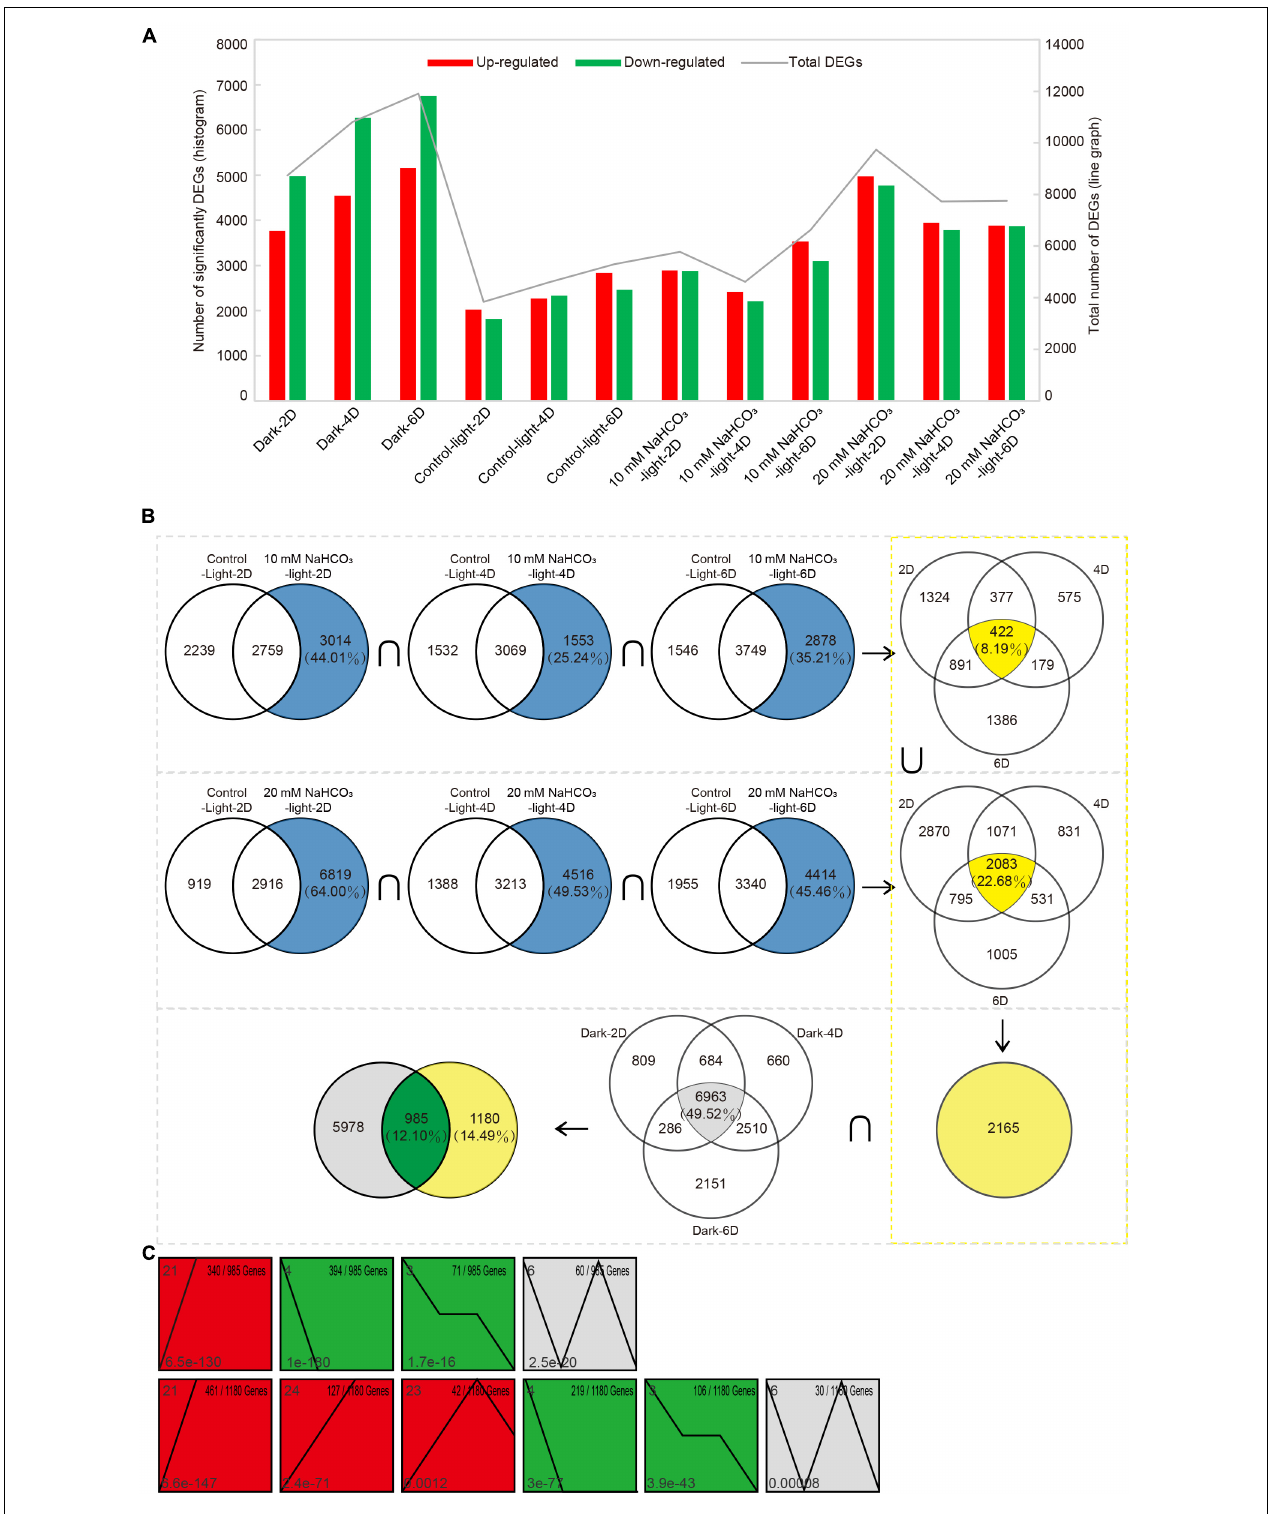
FIGURE 3 | Analysis of differentially expressed senescence-associated genes (SAGs) under alkali stress. (A) The number of differentially expressed genes that were upregulated or downregulated during leaf senescence compared with 0 day control prior to treatment, as assessed using the difference analysis software edgeR at thresholds of | log 2 FC| ≥ 1 and P < 0.05. (B) Venn diagram of DEGs (|log 2 FC| ≥ 1 and P < 0.05) in the 10 mM, 20 mM NaHCO 3 treatments and darkness on day 2, 4, and 6 compared with control-light condition. There were 985 SAGs shared by darkness and NaHCO 3 treatments across three time points. (C) Short time-series expression miner (STEM) analysis of 985 and 1,180 genes across three time points. Each square box indicates a type of expression profile, with the profile order on the upper left and the P -value on the bottom left. Only significantly enriched cluster profiles with a P < 0.05 threshold are shown. Frontiers in Plant Science |